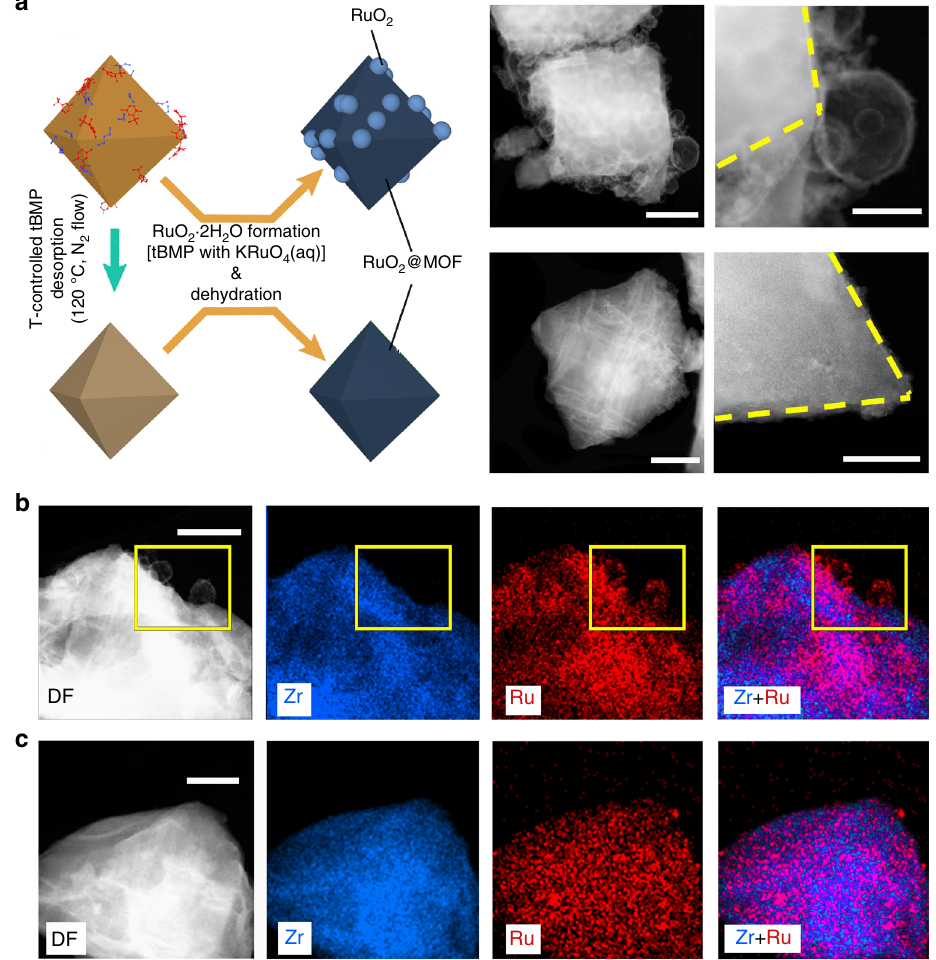
Fig. 2 Controllable RuO 2 guest formation inside (or both inside and outside) MOF-808-P. a RuO 2 can be formed both inside and outside the metal – organic framework (MOF), or only inside the MOF (i.e., RuO 2 @MOF-808-P) via temperature ( T )-controlled selective desorption of the 2-tert-butyl-4 − -methylphenol (tBMP) molecules outside the MOF. Dark- fi eld scanning transmission electron microscopy (DF-STEM) images to the right show spherical shell structures on the outer surface of the MOF crystals (top, for RuO 2 formed inside and outside the MOF, scale bars: 500 nm and 200 nm for left and right) vs. clean MOF crystal edges (bottom, for RuO 2 loaded mostly inside the MOF, scale bars: 500 nm and 50 nm for left and right). The controlled deposition was further veri fi ed by STEM-energy-dispersive X-ray spectroscopy (EDS) Zr and Ru mappings for b RuO 2 formed inside and outside the MOF, scale bar: 200 nm, and c RuO 2 loaded mostly inside the MOF, scale bar: 100 nm. The yellow frames in ( b ) highlight the Ru-based spherical shell structures. Raw images are provided as a Source Data fi